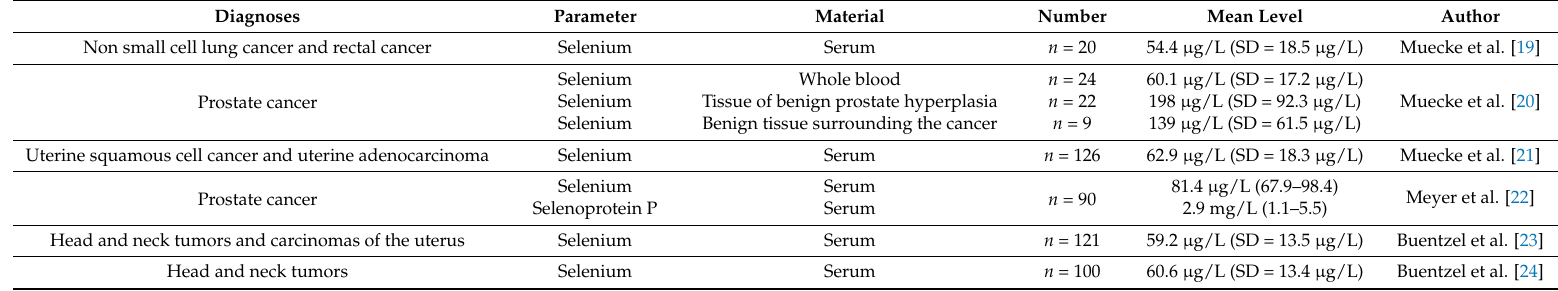
Table 2. Number and mean values of patients included in studies of our working group with measurement of Se and